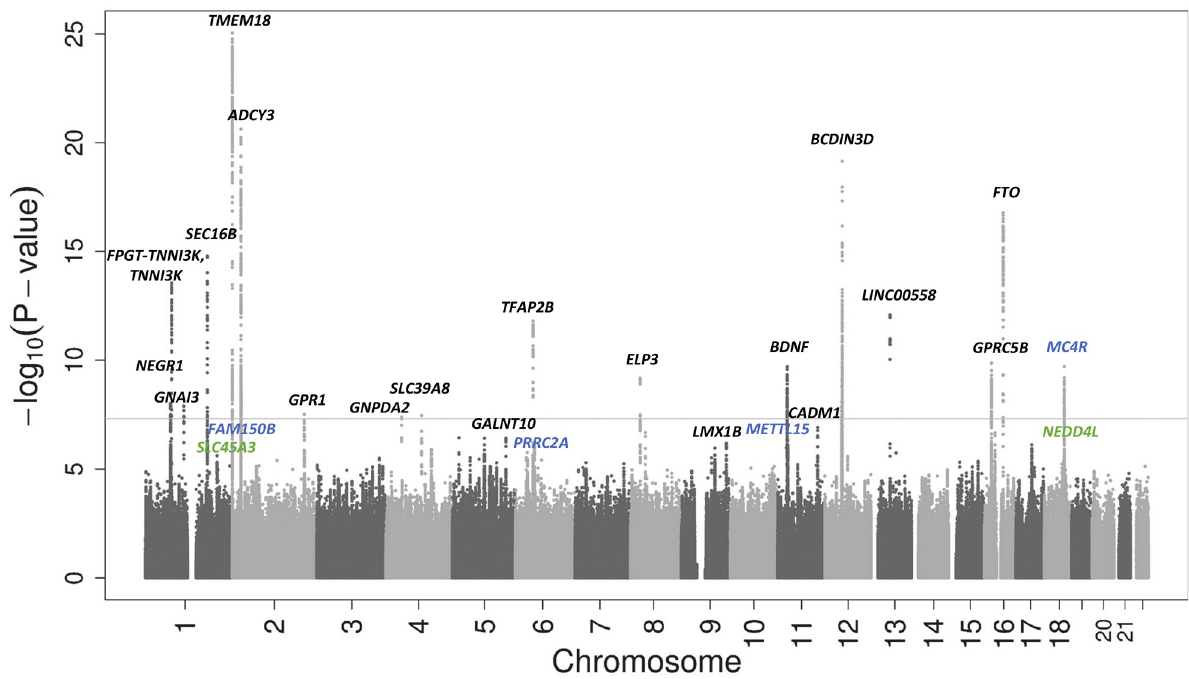
Fig 1. Manhattan plot of results of the discovery meta-analysis of 26 single study GWAS. On the x-axis the chromosomes are shown. On the y- axis the–log 10 of the P-value is shown. Novel SNPs are shown in green. Independent SNPs are shown in blue. Known SNPs are shown in black. The genome wide significance cutoff of 5 × 10 − 8 is represented by the grey dotted